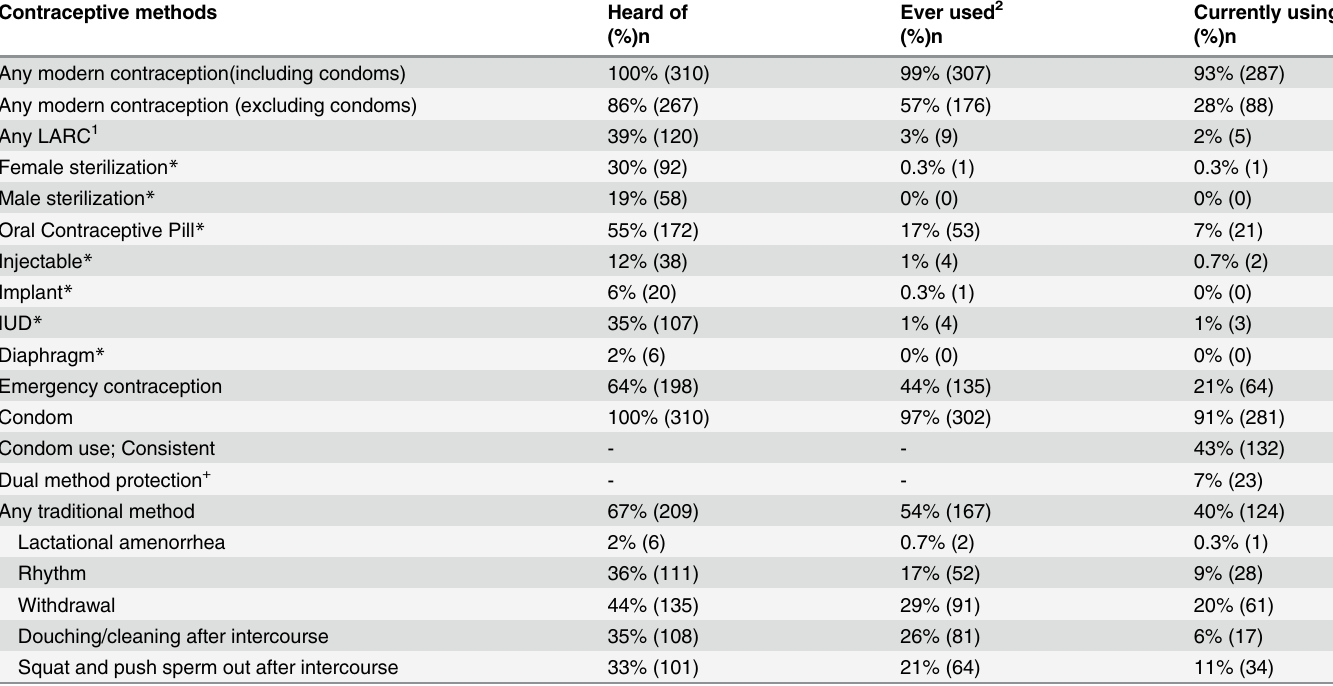
Table 3. Awareness and use of different types of contraception among adolescent female sex workers (N = 310). Contraceptive